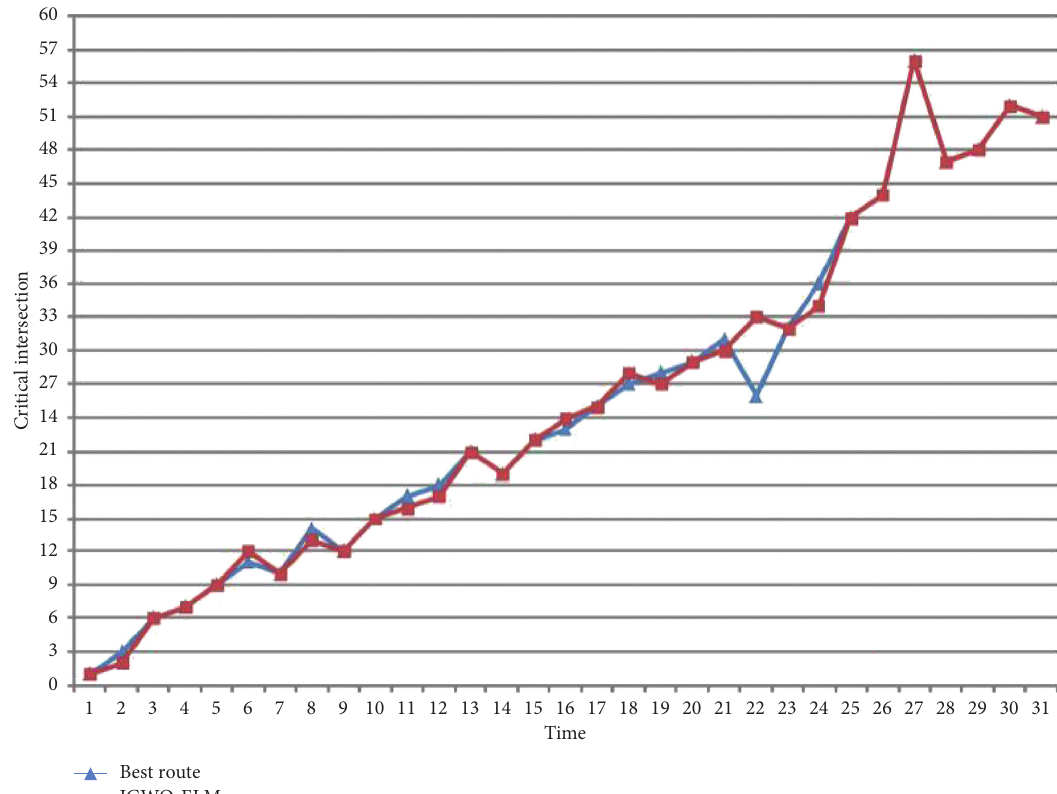
Figure 2: Comparison of IGWO-ELM route and optimal route in Figure 2.